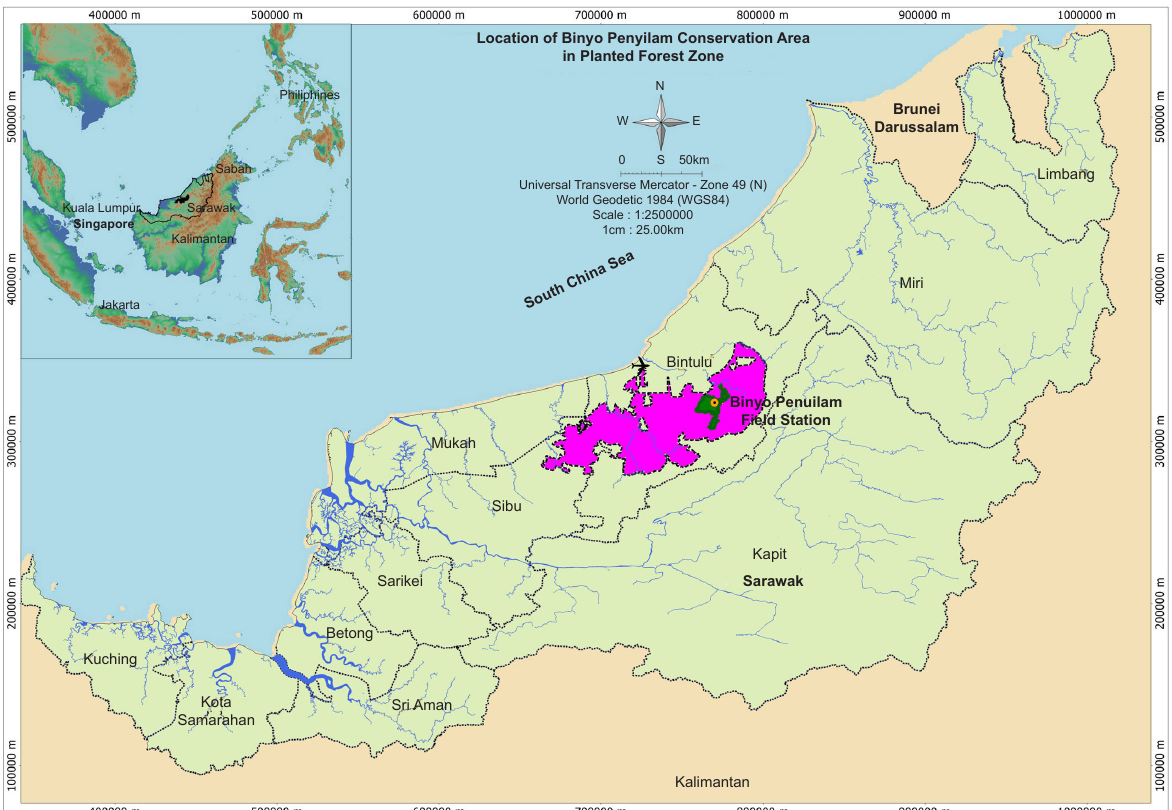
Image 1. Map of Sarawak showing the location of the Sarawak Planted Forest Project and the Binyo Penyilam Conservation